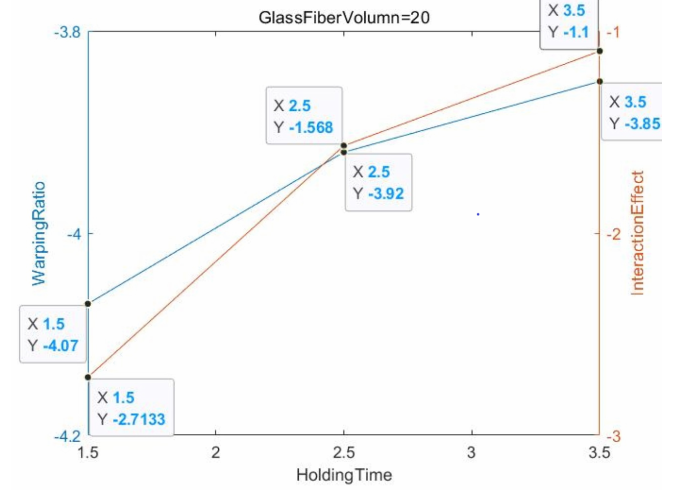
Figure 7. GF Volume = 20.